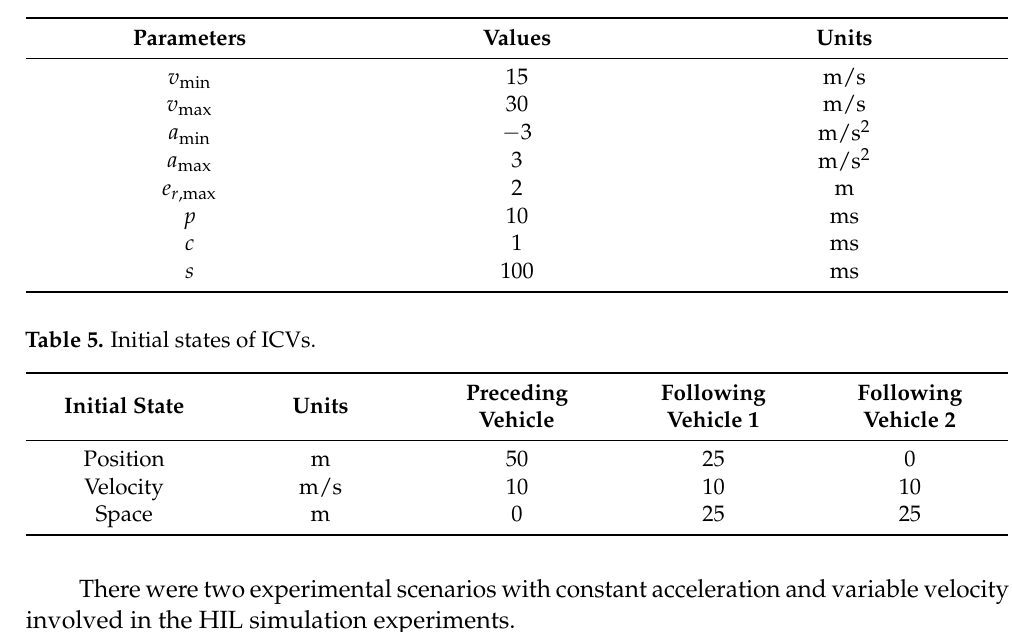
Table 4. Parameter settings of the model predictive control strategy.